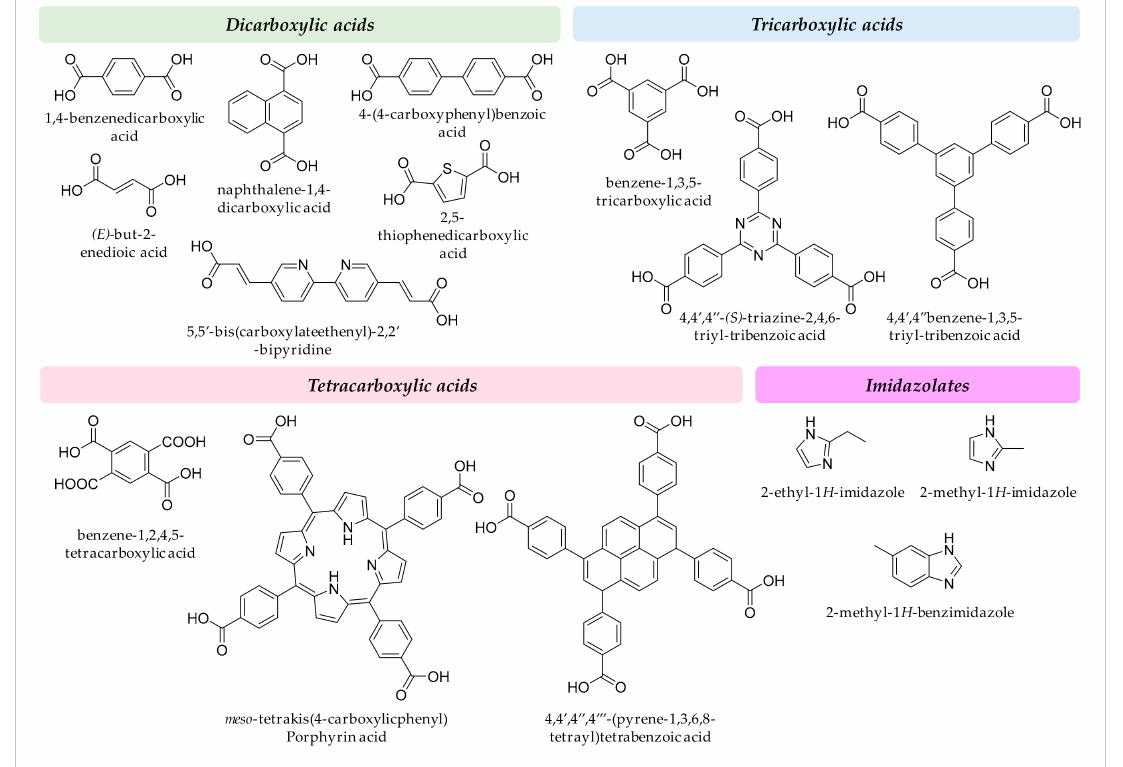
Figure 3. Representative examples of organic ligands used in MOF